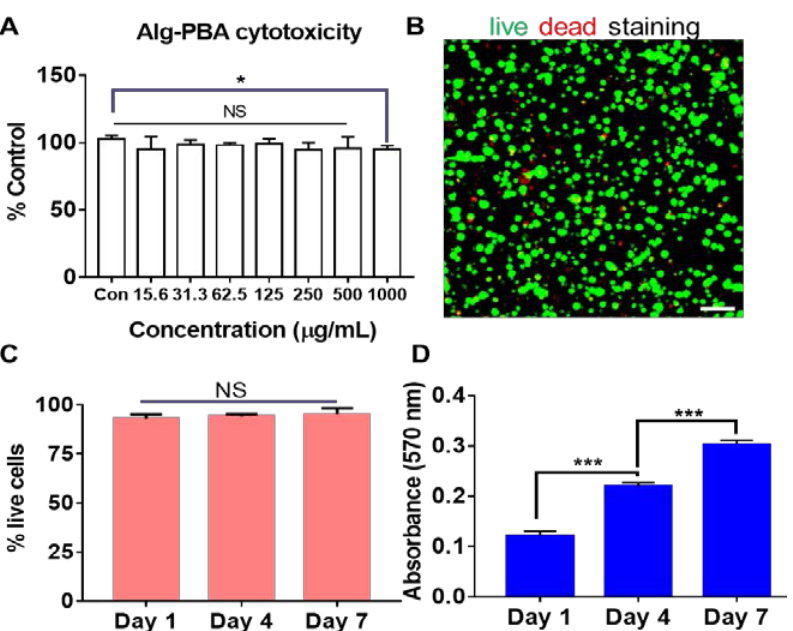
Figure 4. Cytocompatibility of Alg-PBA dynamic hydrogel precursor and dynamic alginate hydrogels. ( A ) Cytotoxicity of synthesized Alg-PBA conjugate towards L929 cell determined by MTT assay. ( B ) Representative live and dead staining of L929 cells in stabilized hydrogel at day 7. ( C ) Viability of L929 encapsulated in hydrogel from day 1 to day 7. ( D ) Cell proliferation of L929 cells in hydrogel from day 1 to day 7. Scale bar = 100 µm. NS: not significant; * p < 0.05; *** p < 0.0 01.